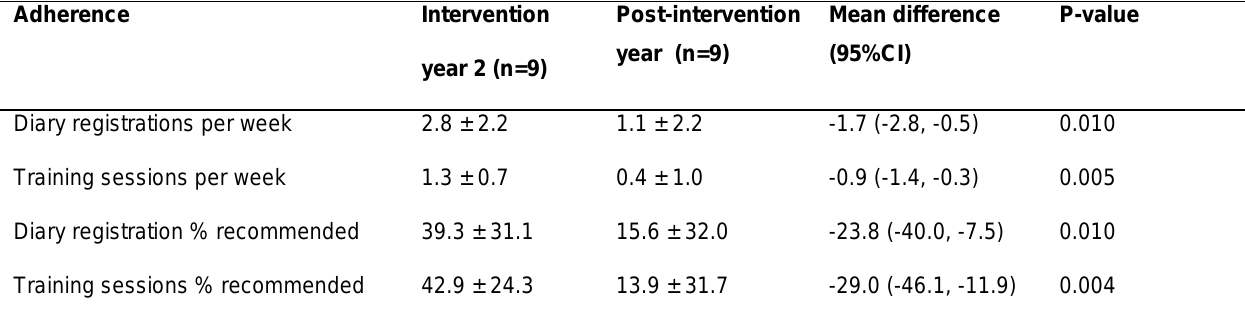
Table 4. Adherence (Second Year of the Telerehabilitation vs. Post-intervention Year) Adherence